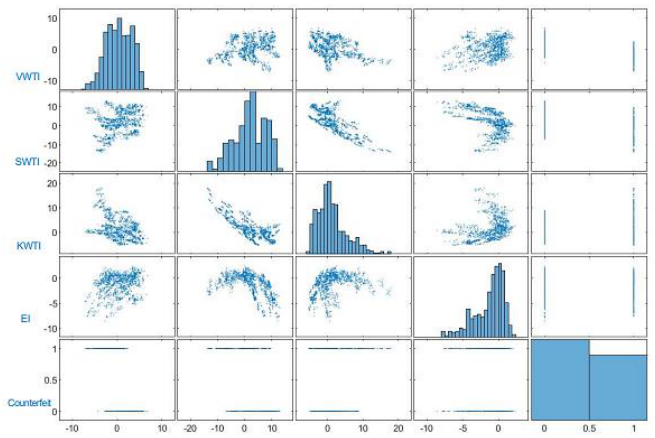
Fig. 1. The scatterplot matrix of the banknote authentication dataset [28].